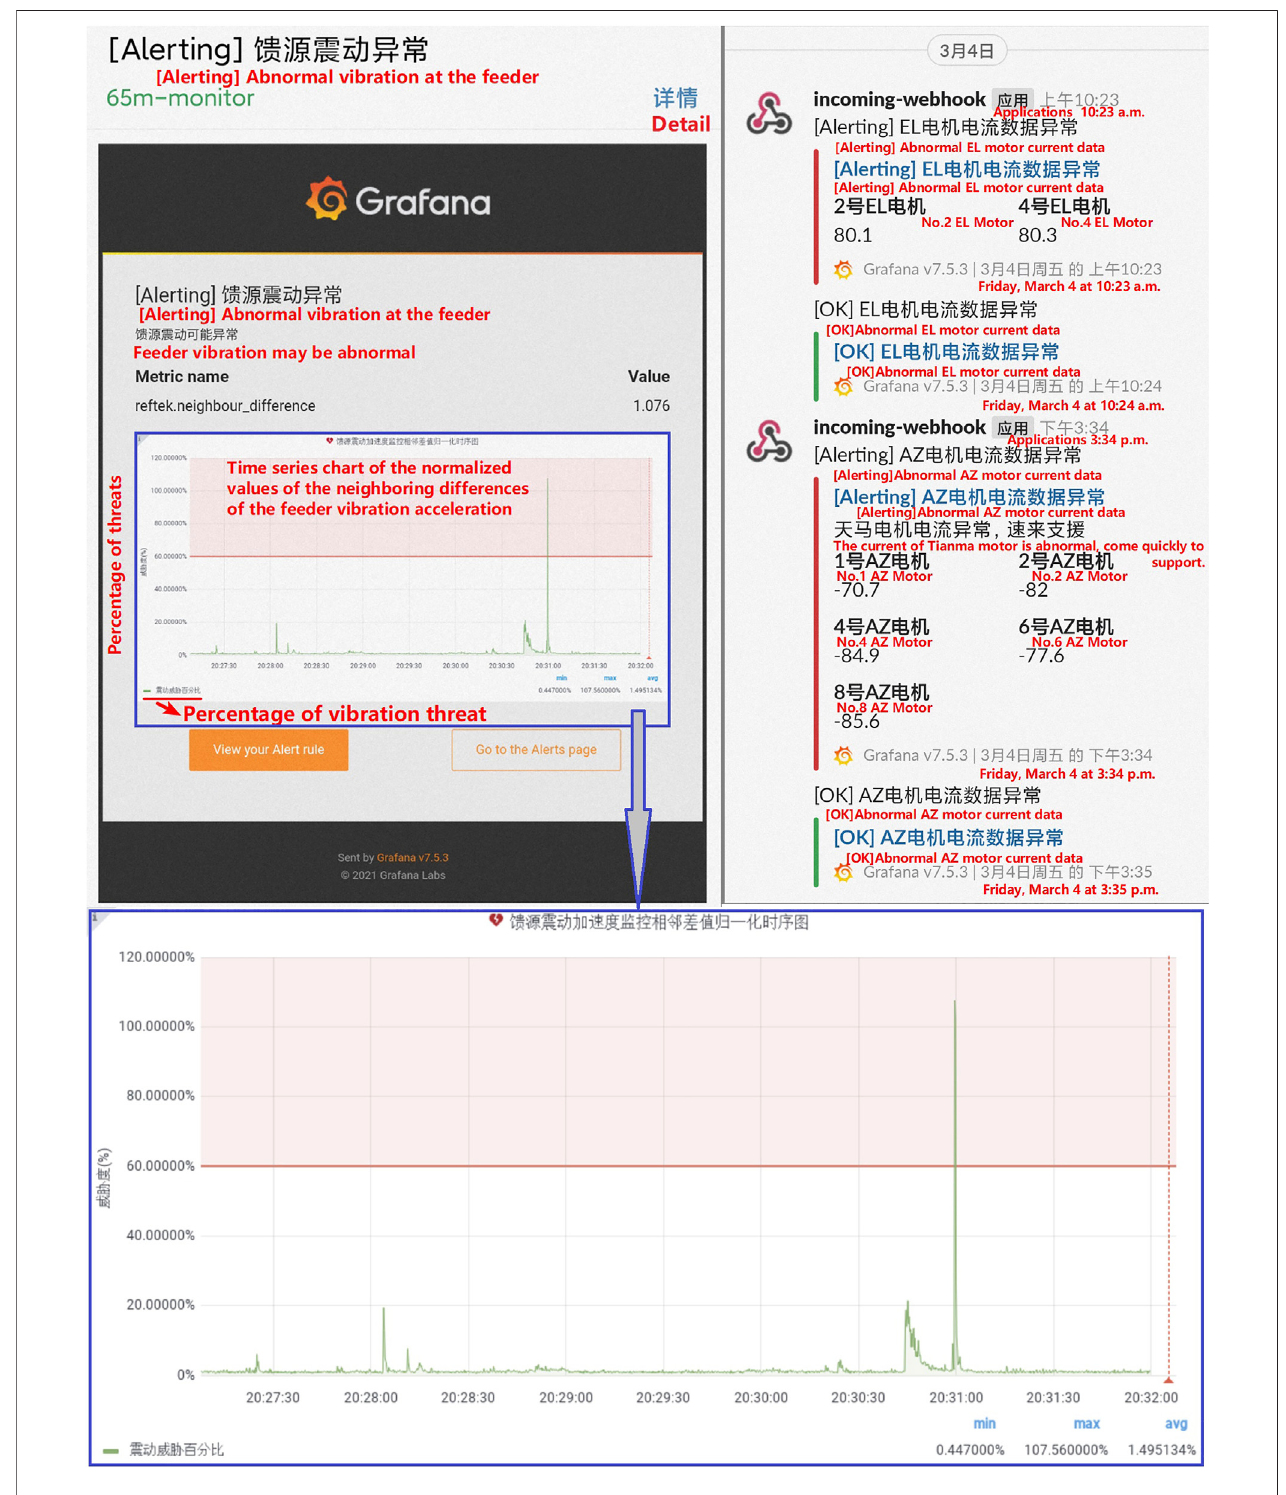
FIGURE 5 | This is a screenshot of the system alert push message. The top-left part is the email message interface, which includes alert values, alert items, value charts, and some alert messages. The bottom half ofthe fi gure, which is marked ‘ C ’ , is achart detailing thedata for this alert. The top-rightpart isthe message interface on the Slack app, which includes alert values, alert items, and some alert messages. The marker “ A ” and marker “ B ” are examples of TMRT alerts.